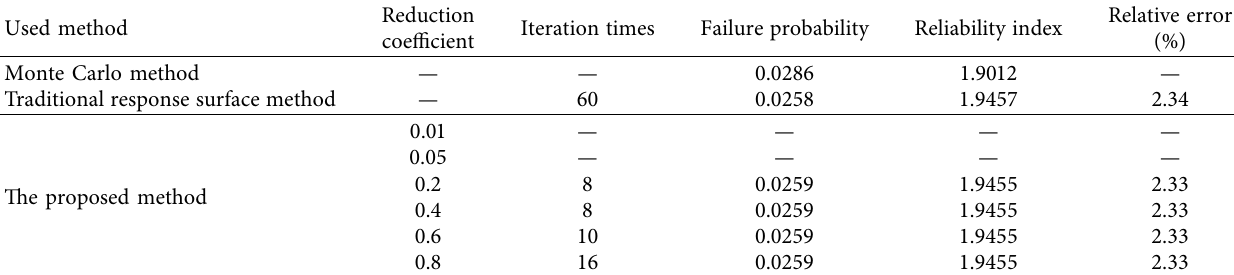
Table 8: Calculation results of example